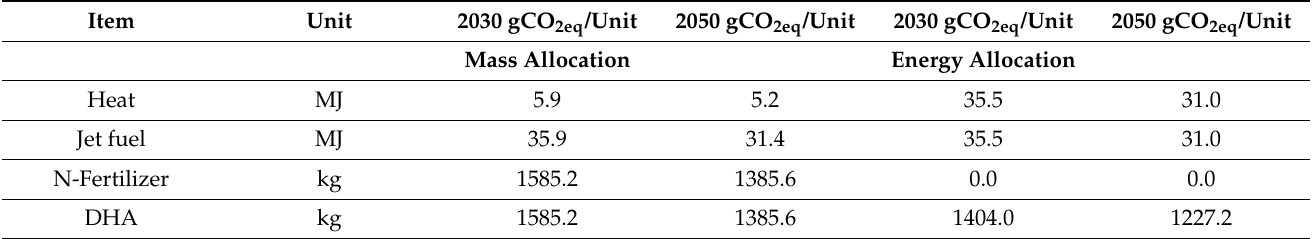
Table 5. Selected emission factors for N-fertilizer, jet fuel, DHA, and district heating from a C. cohnii biorefinery.